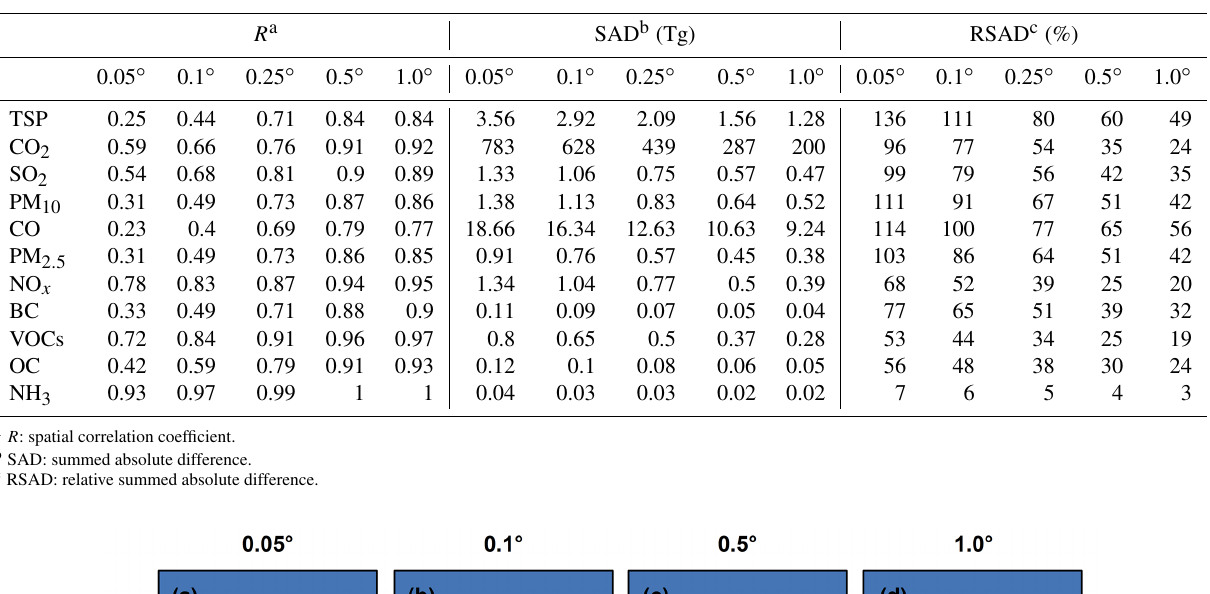
Table 2. Comparison of gridded emissions from MEIC and HB-EI at different resolutions.